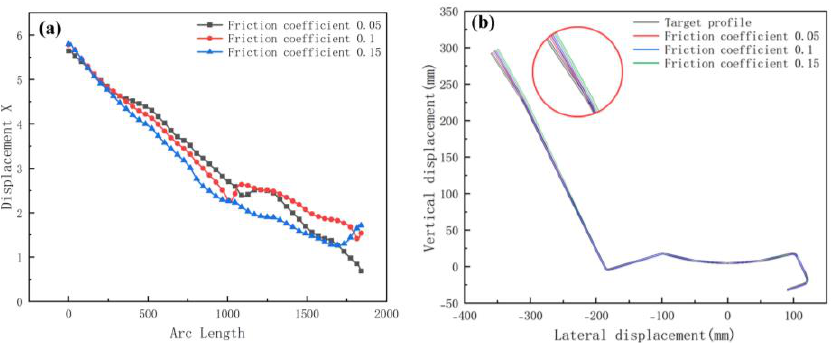
Figure 15. ( a ) Displacement X of strip in 3 friction coefficients; ( b ) cross-section of 3 friction coeffi- cients.